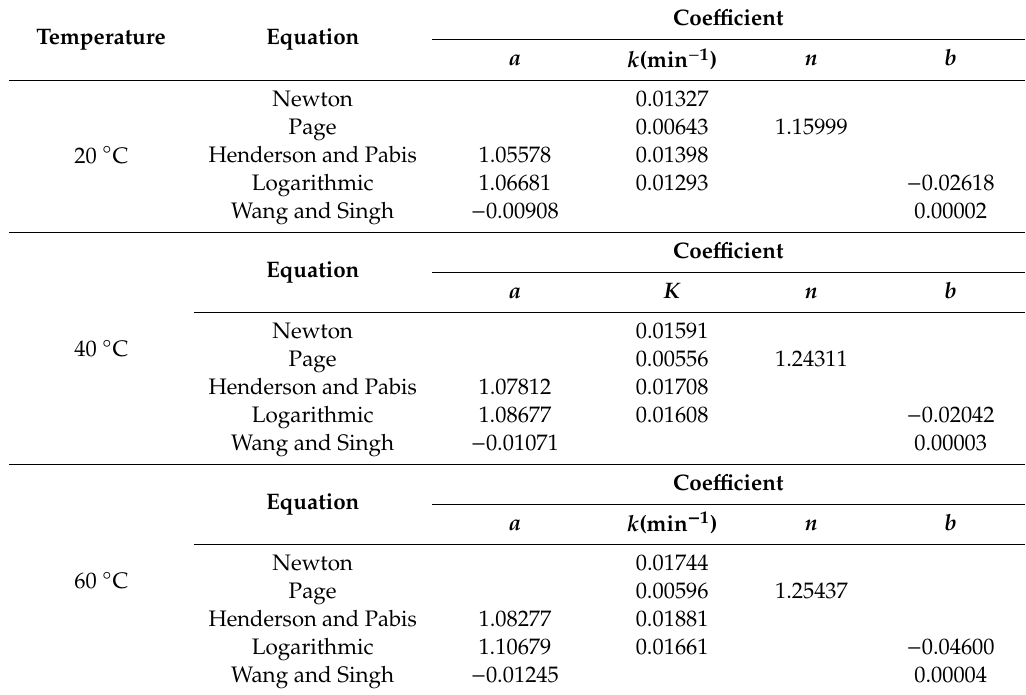
Table 5. Values in the models describing the freeze-drying of Moldavian dragonhead.